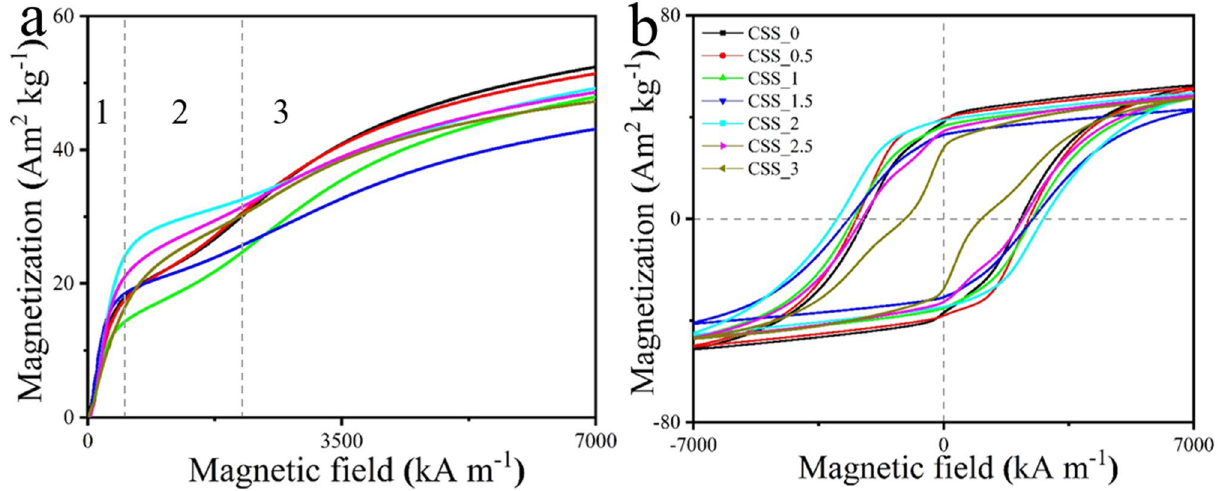
Figure 5. ( a ) The initial magnetization curves of different samples, and ( b ) their hysteresis loops. Software: Origin 2016, www.origi nlab.com.